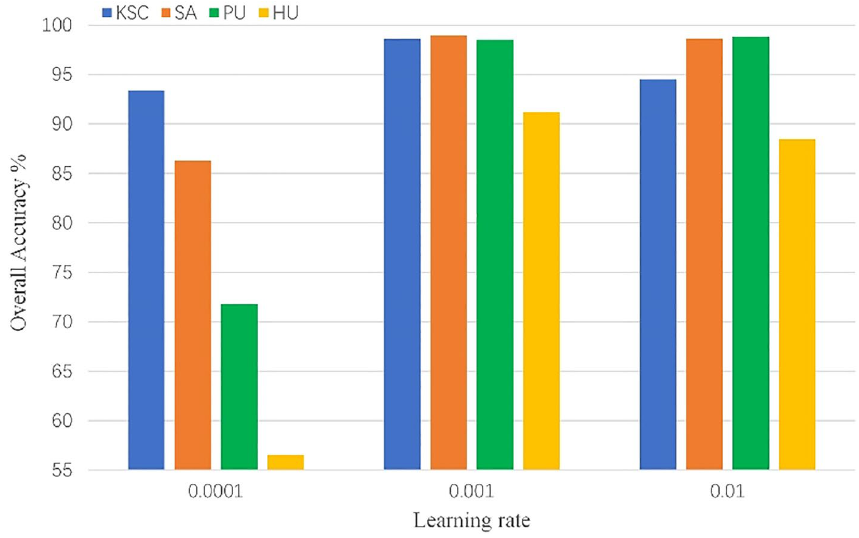
Figure 9. OA (%) of DBFFT with different learning rate in the four datasets.